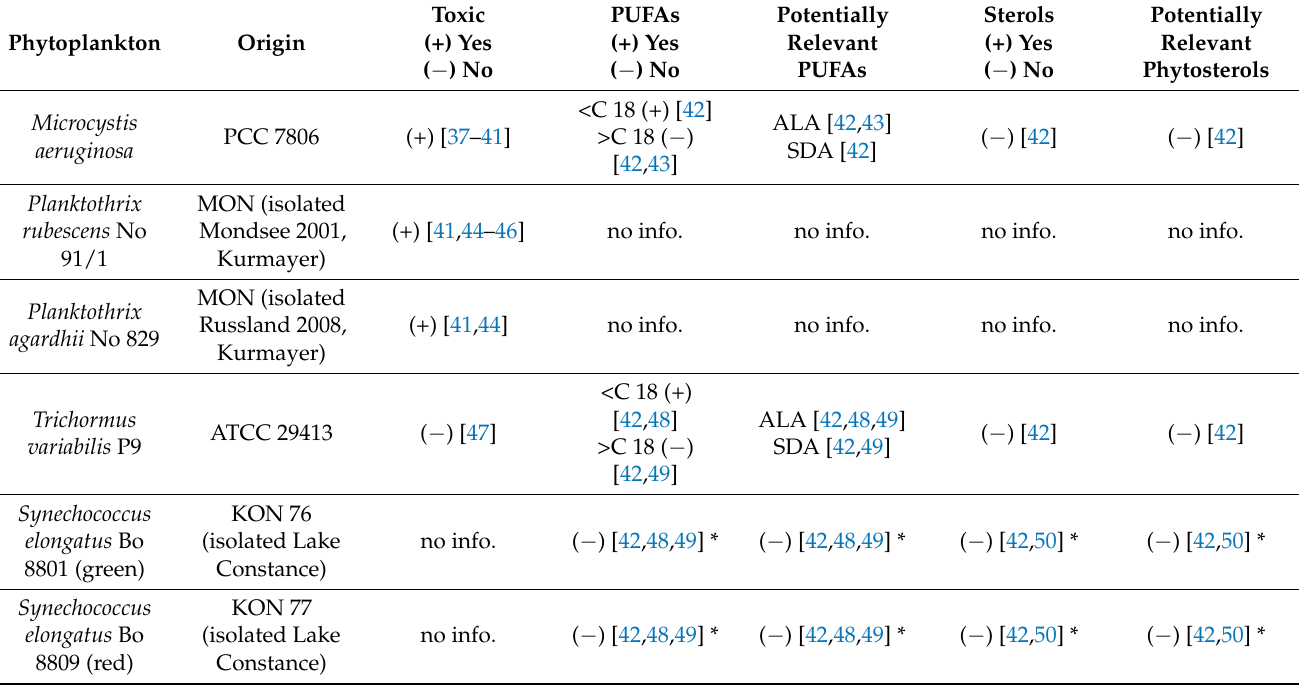
Table 1. Phytoplankton species used as dietary sources for Daphnia and their respective origin, toxicity, polyunsaturated fatty acid (PUFA), and sterol provisioning